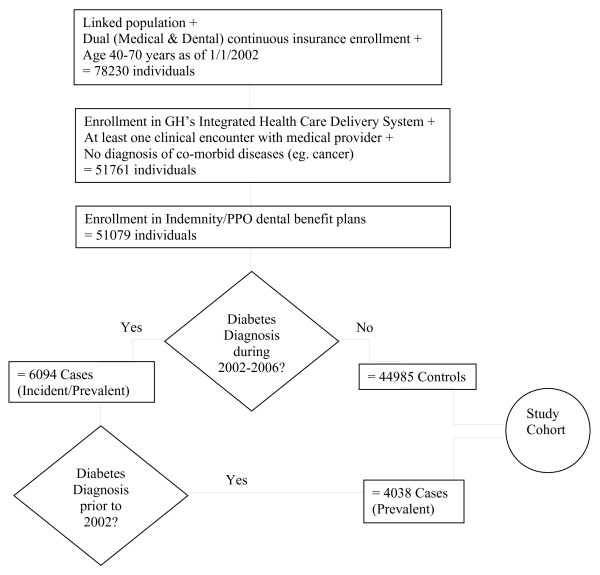
Flow-chart for study cohort.